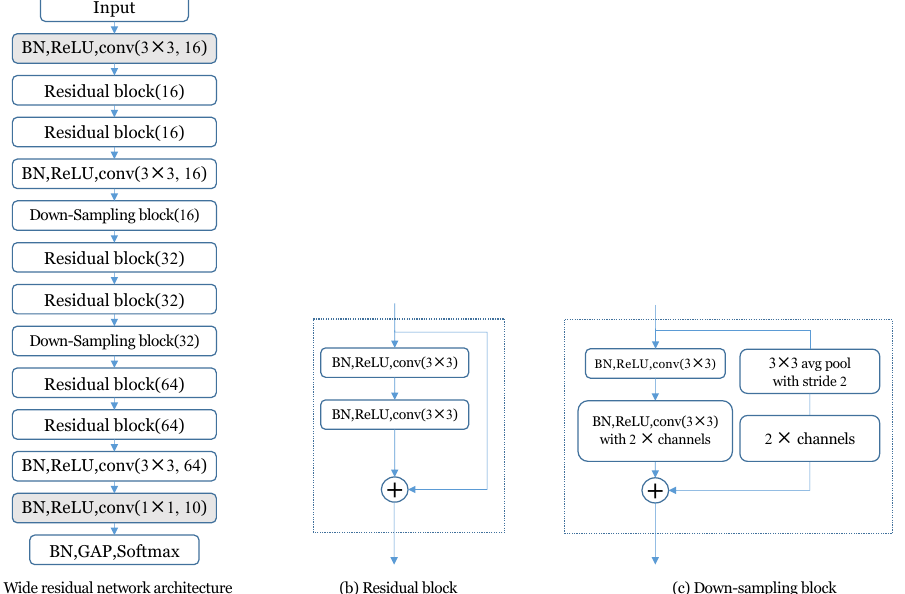
Figure 7. Schematic diagrams of ( a ) the ASC model with wide ResNet (WRN), ( b ) the residual block, and ( c ) the down-sampling block. The “2 × channels” layer in the down-sampling block is a layer for doubling the number of channels with zero paddings for the skip connection.